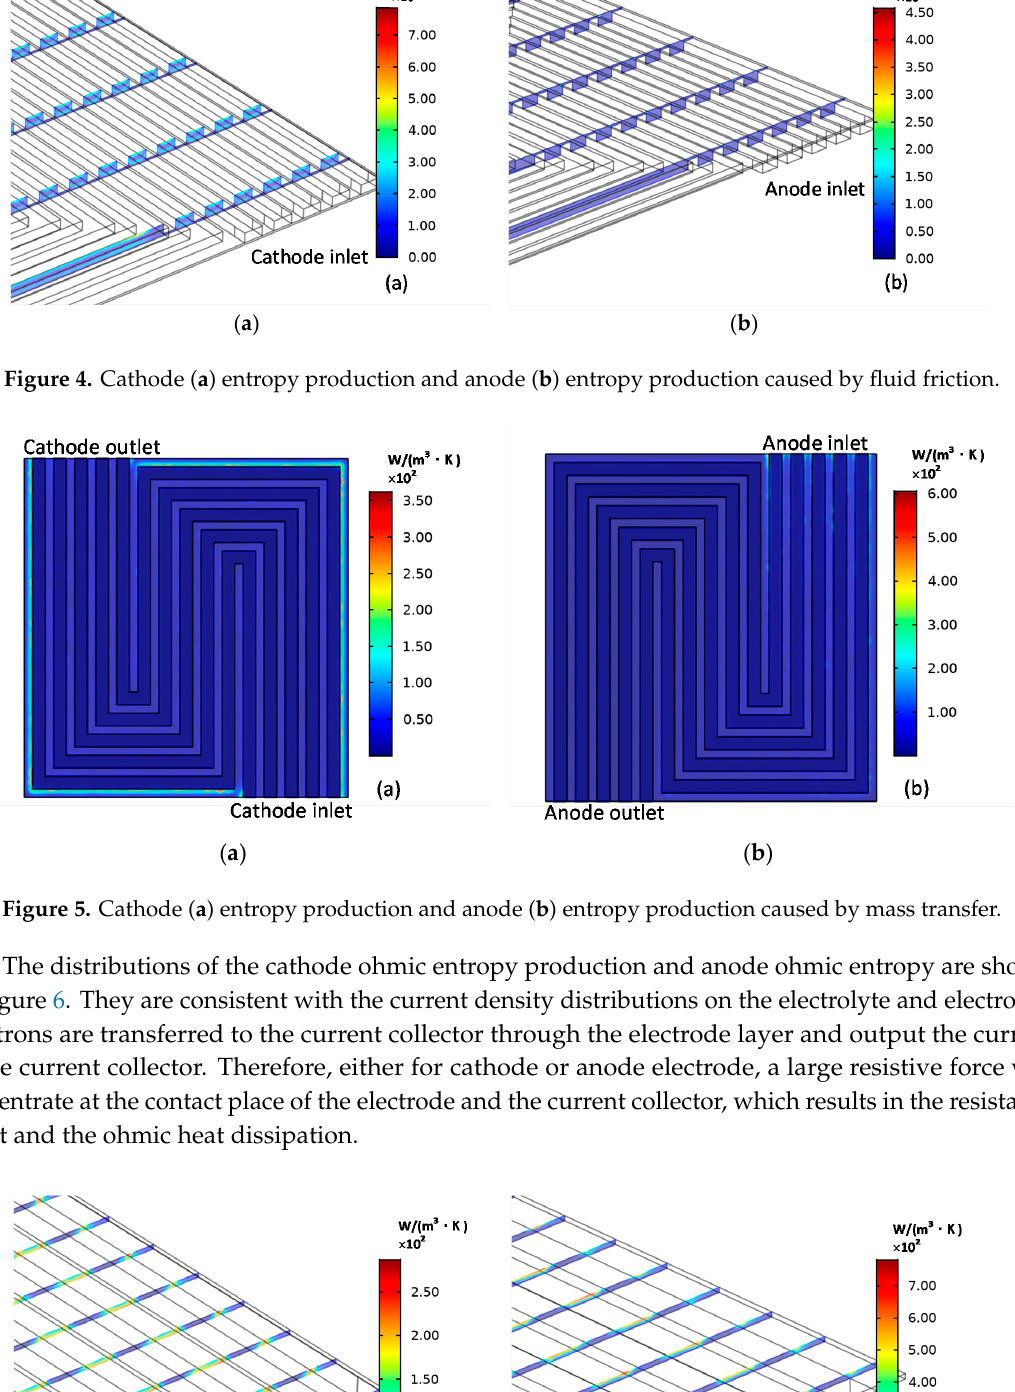
Figure 4. Cathode ( a ) entropy production and anode ( b ) entropy production caused by fluid friction.